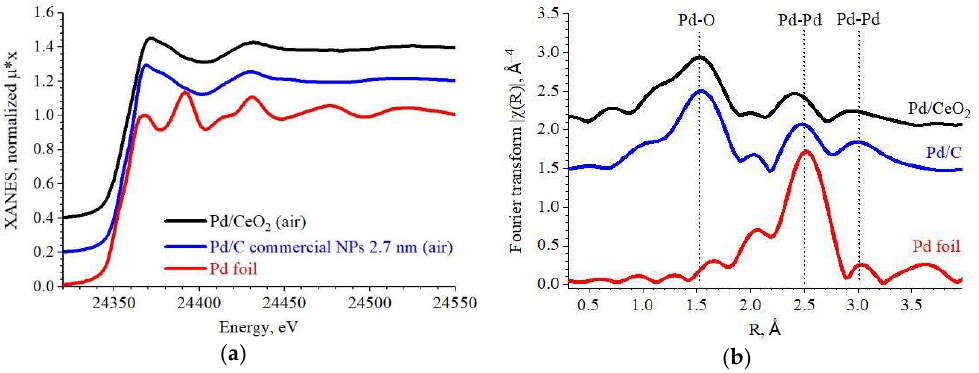
Figure 3. ( a ) Pd K-edge X-ray absorption near edge structure analysis (XANES) spectra; ( b ) Fourier